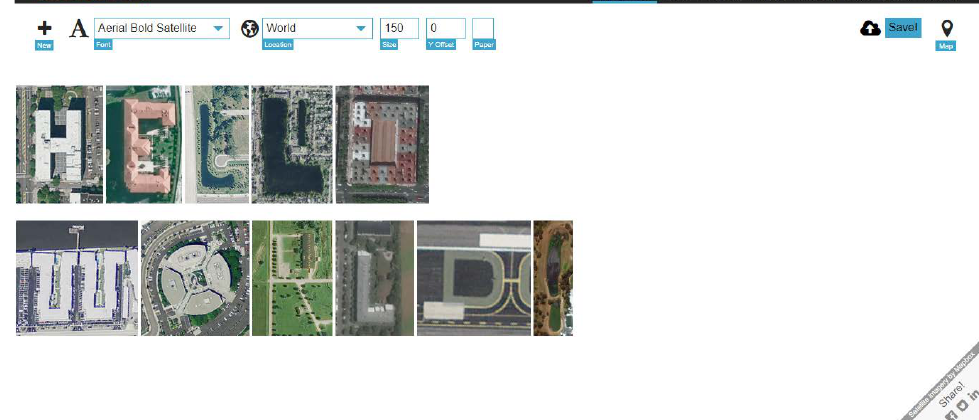
Figure 4: Benedikt Groß and Joey Lee, The Aerial Bold (since 2016). Project website: typewriter. Image courtesy of Benedikt Groß.